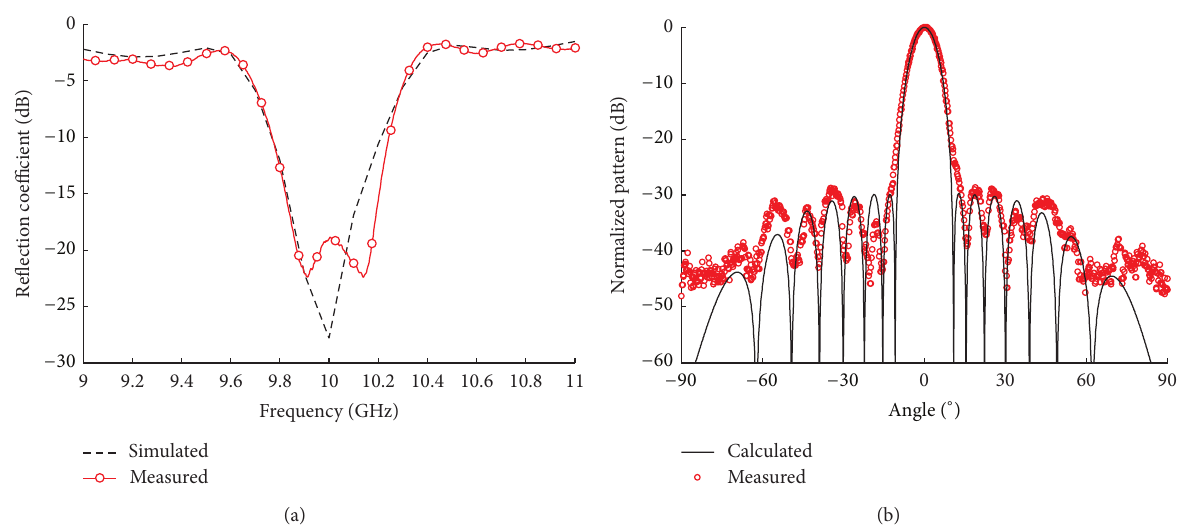
Figure 12: Measured results of the resonant waveguide slotted array. (a) Reflection coefficients. (b) Radiation pattern.